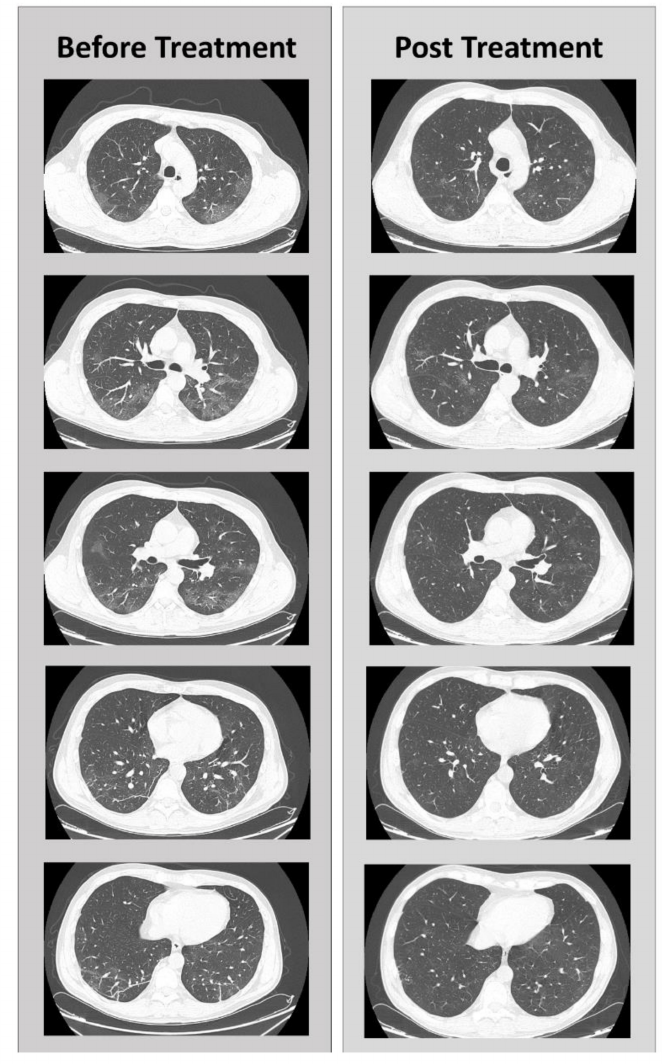
Figure 2. Comparison of CT scans before and after adenosine treatment, in di ff erent sections. During and after treatment, adverse events related to the use of adenosine were not